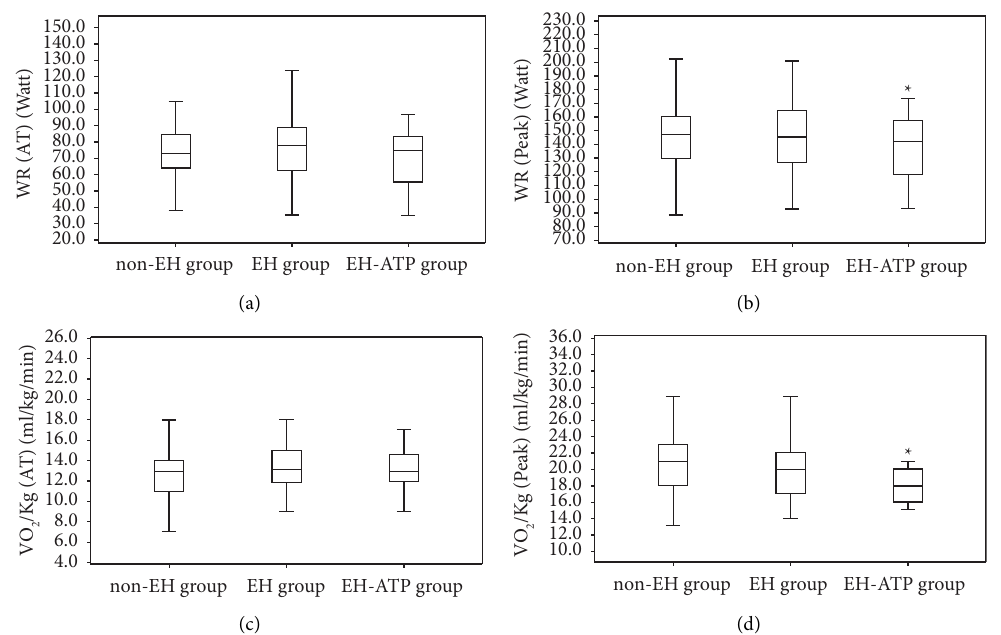
Figure 3: Comparison of cardiopulmonary ftness during exercise.